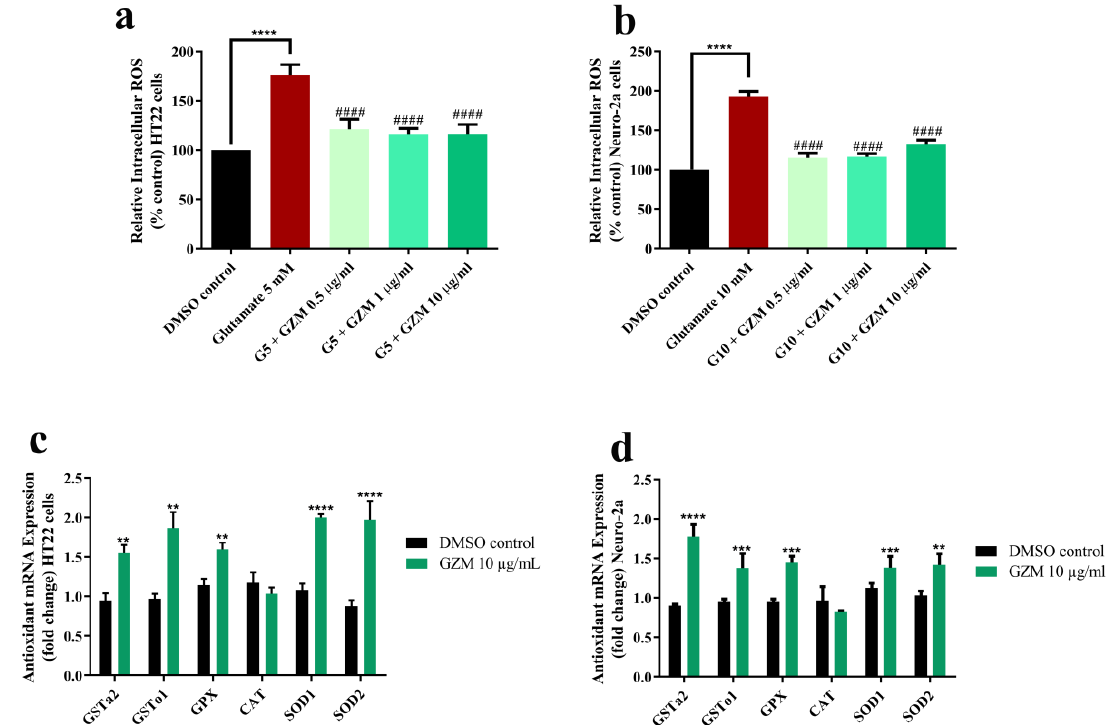
Figure 4. Antioxidant effects of GZM extract on glutamate-induced oxidative stress. GZM extract ameliorated ROS level in HT22 ( a ) and Neuro-2a ( b ) cells and induced the expression of antioxidant genes in HT22 ( c ) and Neuro-2a ( d ) cells ( n = 3; ** p < 0.01, *** p < 0.001, and **** p < 0.0001, DMSO control vs. glutamate treatment alone; #### p < 0.0001, glutamate treatment alone vs. glutamate and GZM extract treatment). The details of statistical values are provided in Table S5 (Supplementary Materials).